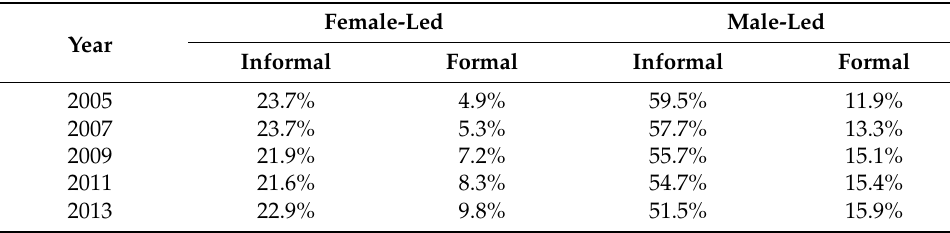
Table 2. Shares of male-led and female-led firms in formal and informal sectors.